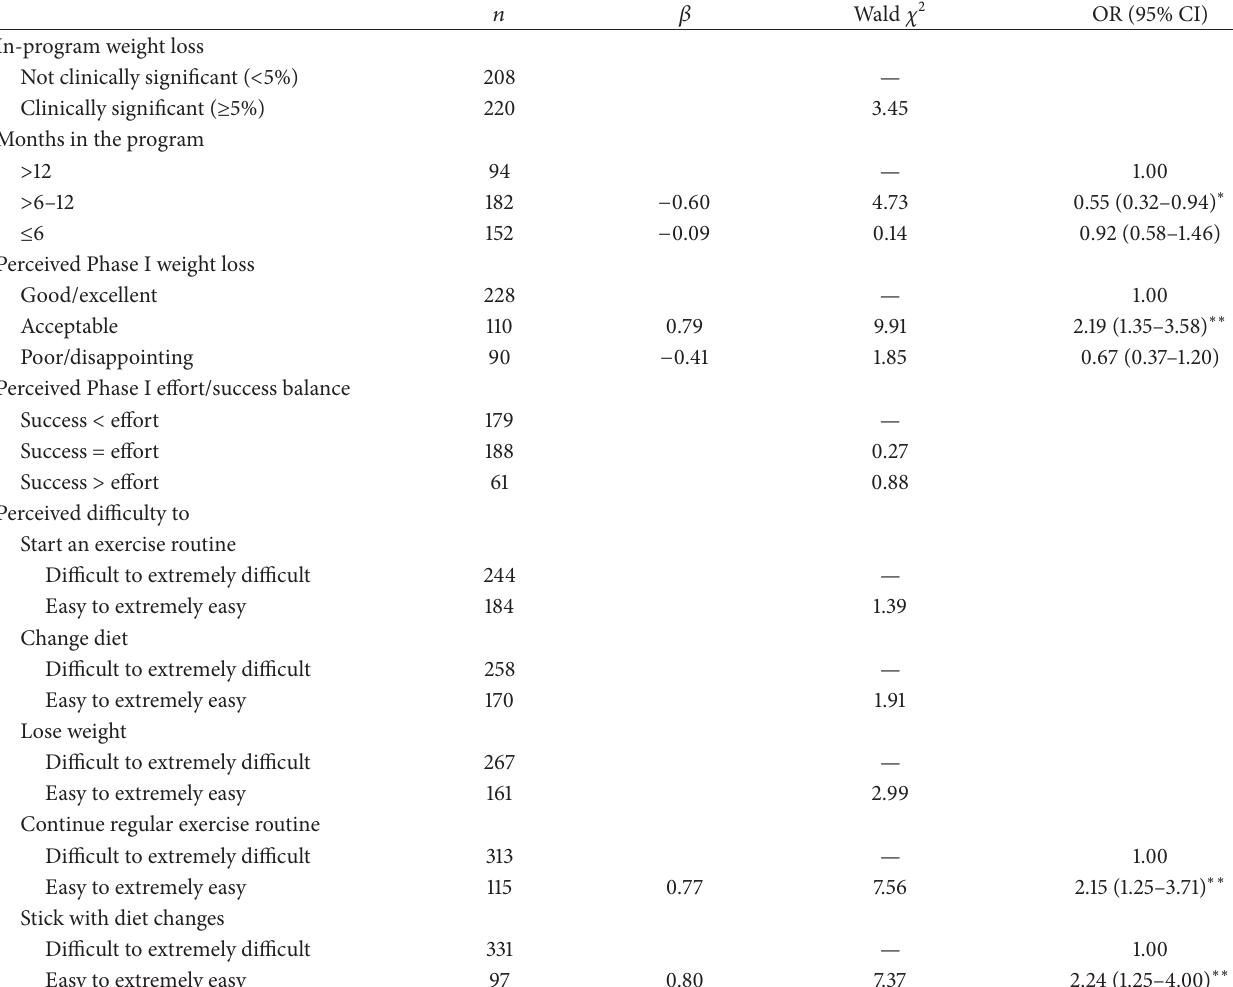
Table 3: In-program predictors of weight loss maintenance ( 𝑁 = 428 )—Model